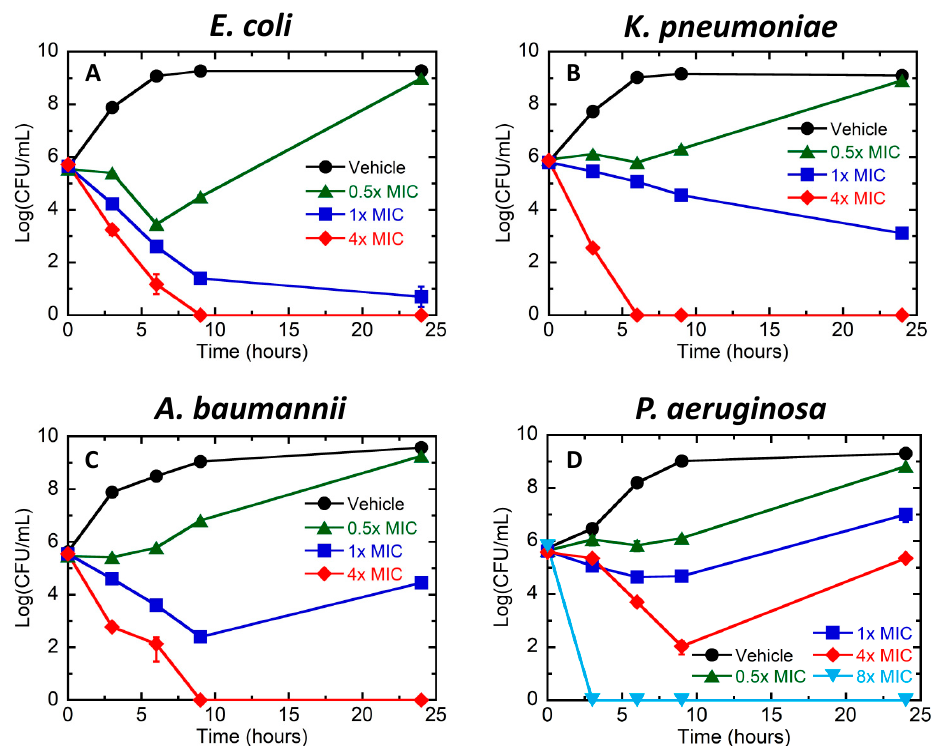
Figure 2. Time–kill curves for E. coli 25922 ( A ), K. pneumoniae 13883 ( B ), A. baumannii 19606 ( C ), and P. aeruginosa 27853 ( D ) treated with DMSO vehicle or TXH11106 at the indicated concentrations. Each experimental data point represents the average of two replicates, with the error bars reflecting the standard deviation from the mean.